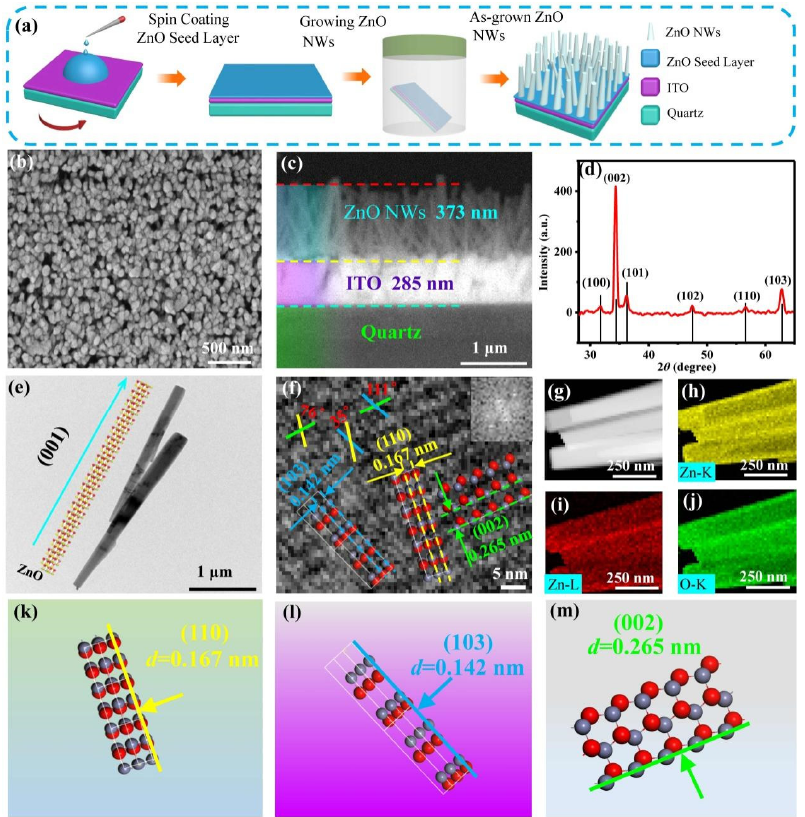
Figure 2. Preparation and structural characterization of ZnO NWs. ( a ) Schematic diagram illustrat- ing the preparation process of ZnO NWs grown by hydrothermal method. ( b ) Top view SEM image. ( c ) Cross-sectional SEM image. ( d ) XRD spectrum. ( e ) TEM image. ( f ) HRTEM image of individual ZnO NWs (Inset: FFT spectrum of ZnO NWs). ( g ) STEM image of ZnO NWs. ( h – j ) Elemental mapping of Zn and O. ( k – m ) Schematic diagrams illustrating the crystal structures of ZnO NWs with (110), (103) and (002)